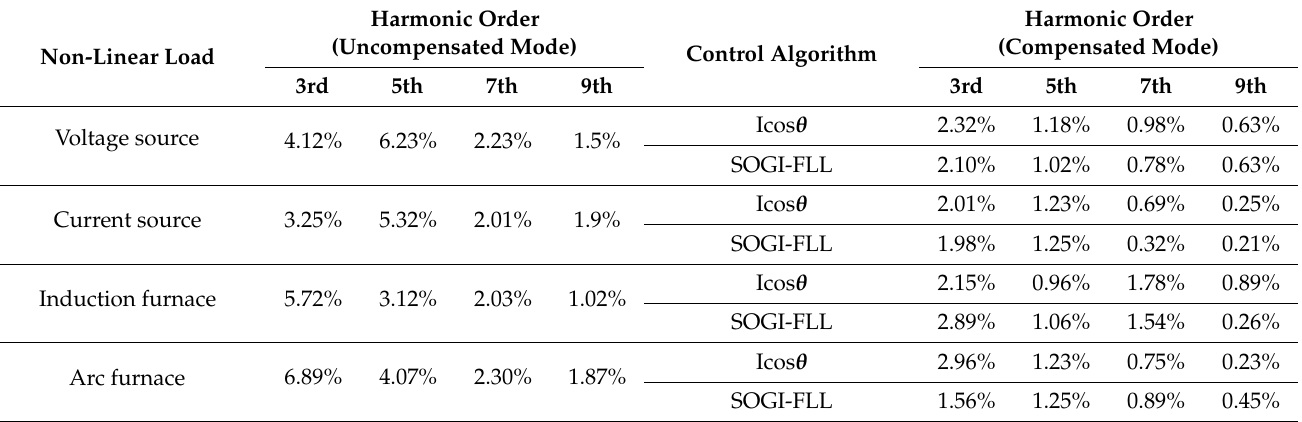
Table 3. Comparative source current harmonic analysis in